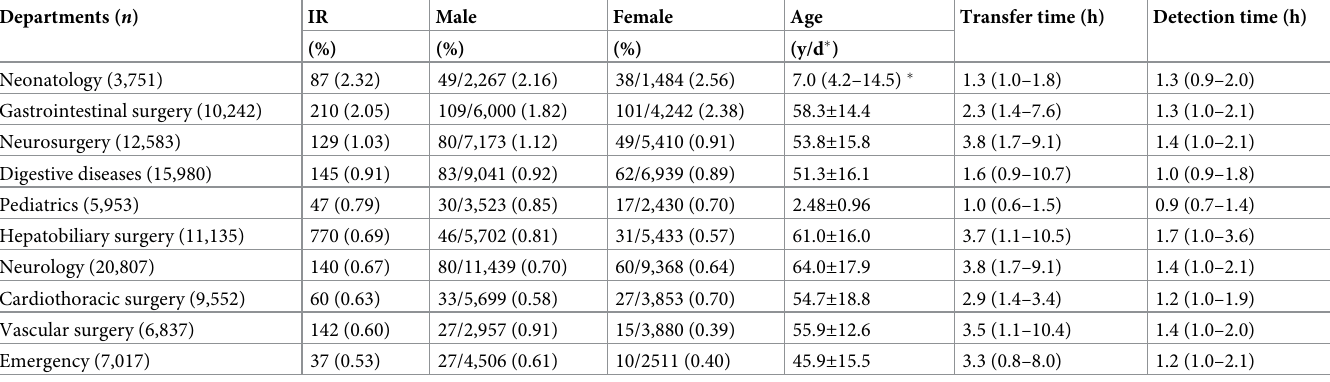
Table 4. The top 10 departments with the high incidence rate of lipemia (n =